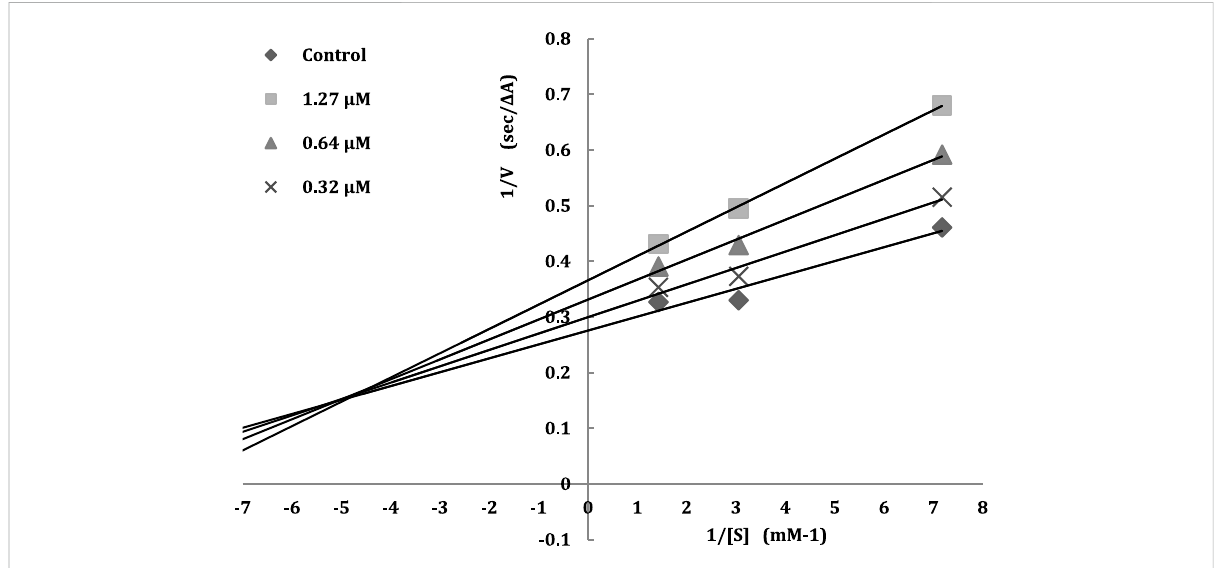
FIGURE 2 The Lineweavere-Burk plot for the inhibition of AChE by compound 5f with increasing substrate concentration.